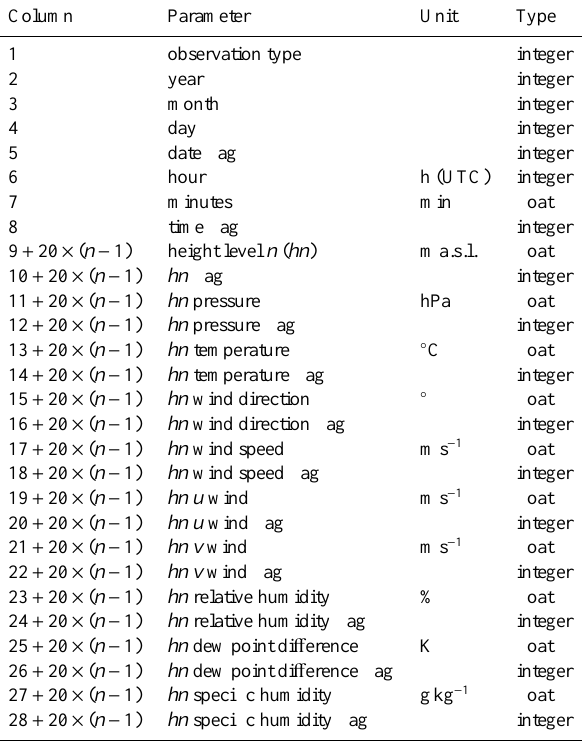
Table 8. Definition of the columns in the fixed station upper-air pressure level format ASCII files used for the ERA-CLIM data. Suf- fices .1 / .2 added to flag values signify observation values obtained during ascent / descent of a kite or captive balloon (see Table 7). n runs from 0 to